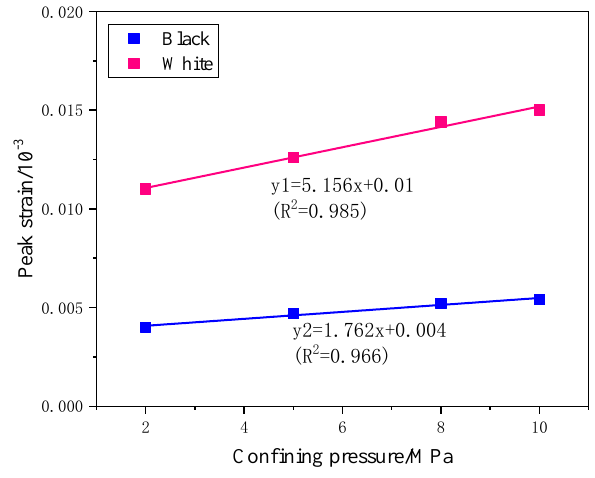
Figure 11. Relationship between peak axial strain and confining pressure.